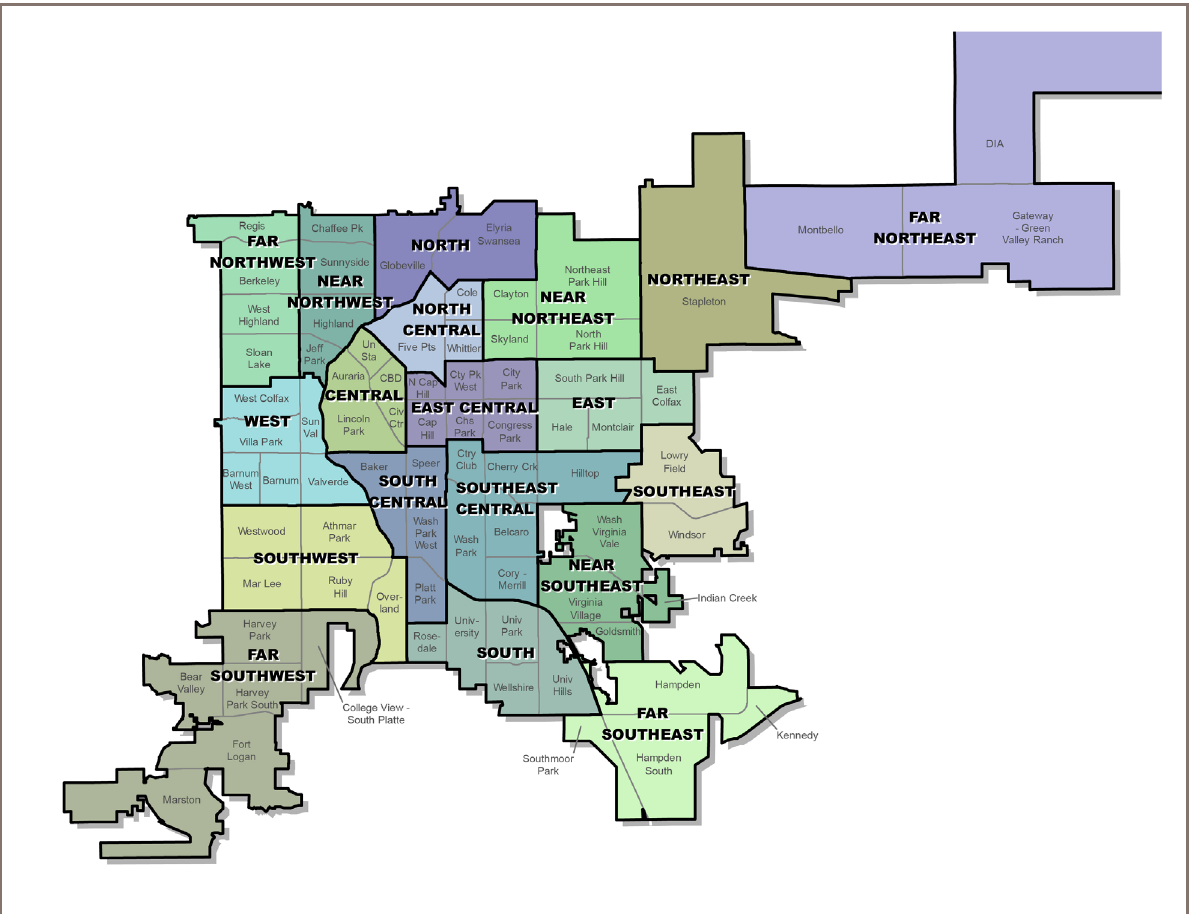
Figure 2: Neighborhood Planning